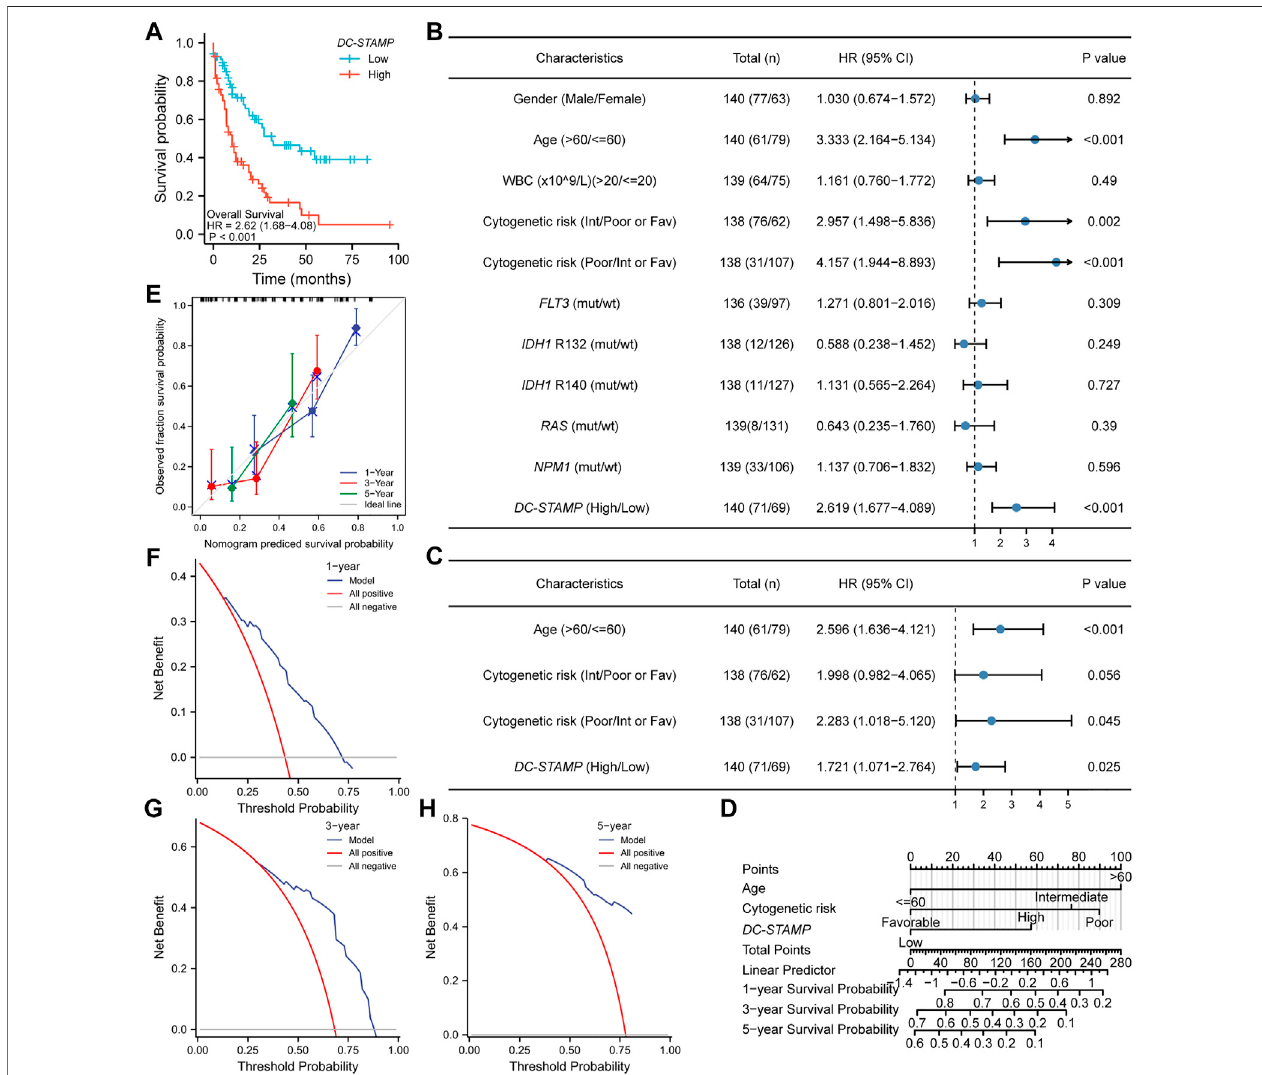
FIGURE 3 | Poor prognostic value of DC-TAMP expression in AML. (A) KM curve analysis of overall survival (OS) between high and low DC-STAMP expression groups. (B) Univariate analyses of OS showed by forest plot. (C) Multivariate analyses of OS showed by forest plot. (D) Nomogram integrates DC-STAMP and other prognosticfactors inAML. (E) Calibration curve ofnomogram.TheDCAcurves ofnomogram(F)by1 year, (G) 3 years,and (H) 5 years(mut; mutation, wt;wildtype,Int; intermediate, Fav; favorable).